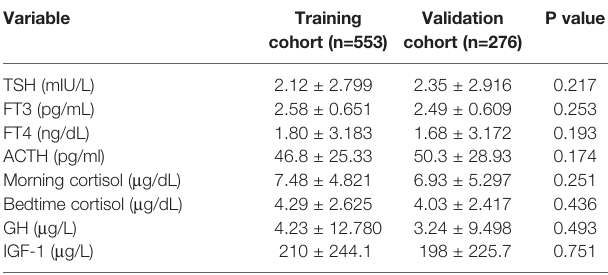
TABLE 1 | Characteristics of patients with PAs in the training and validation